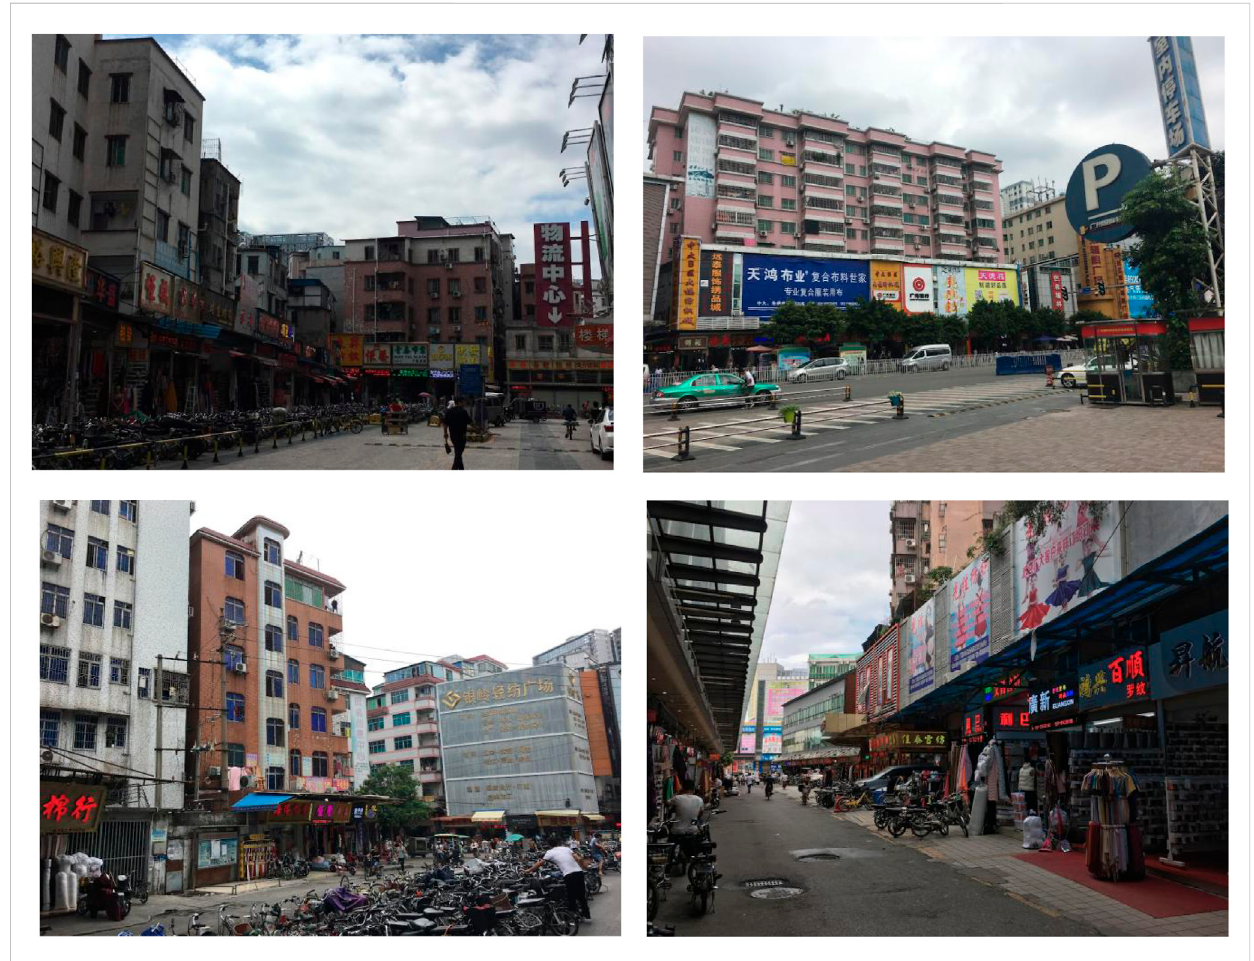
FIGURE 8 Rapid Growth of Informal Housing in Guangzhou (Source: Photo by